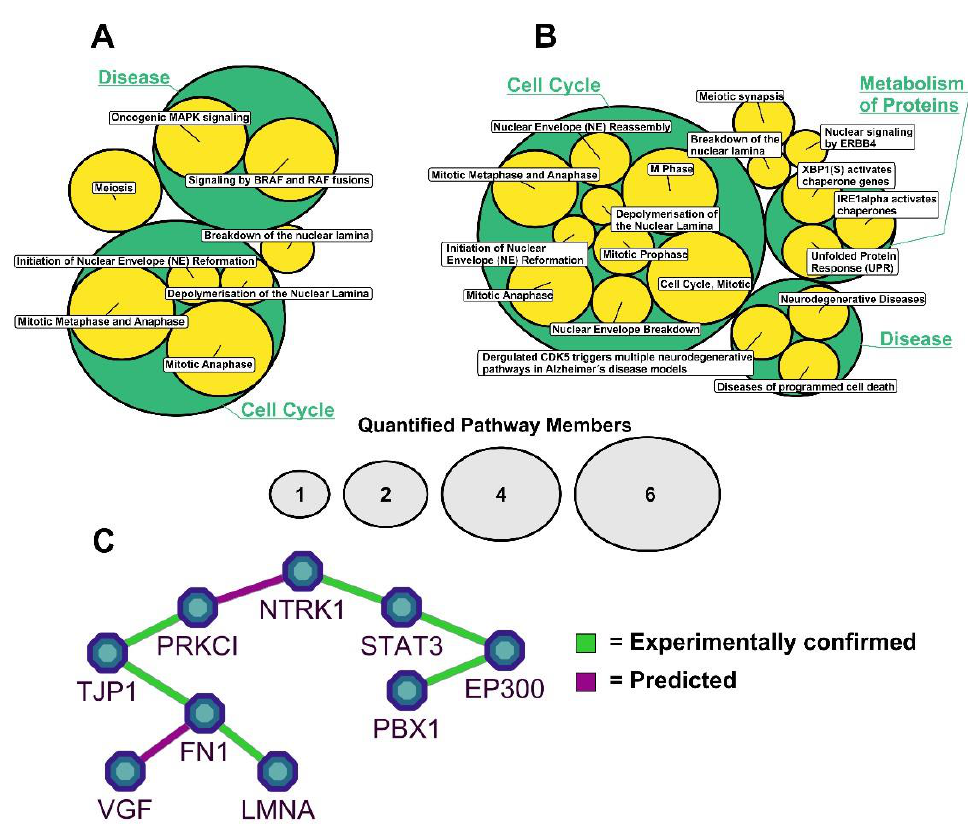
Figure 5 . Pathway and network analysis of regulated proteins and phosphosites. Significantly differentially abundant proteins ( A ) and p-sites ( B ) were annotated with and analyzed for enrichment of regulated Reactome pathways. Bubbles illustrate the hierarchical nature of biological pathways and respective sub-pathways; bubble sizes indicate numbers of proteins/p-sites annotated with the respective pathway; only LMNA-containing pathways are displayed. ( C ) STRING protein interaction network illustrating interactors of NTRK1/TrkA and their functional connection to LMNA.